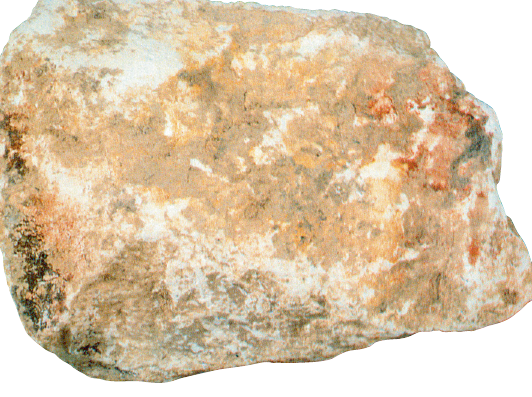
Figure 3. Geißenklösterle, trichromatic painted limestone, Aurignacian. Photo: H. Jensen, Univ.